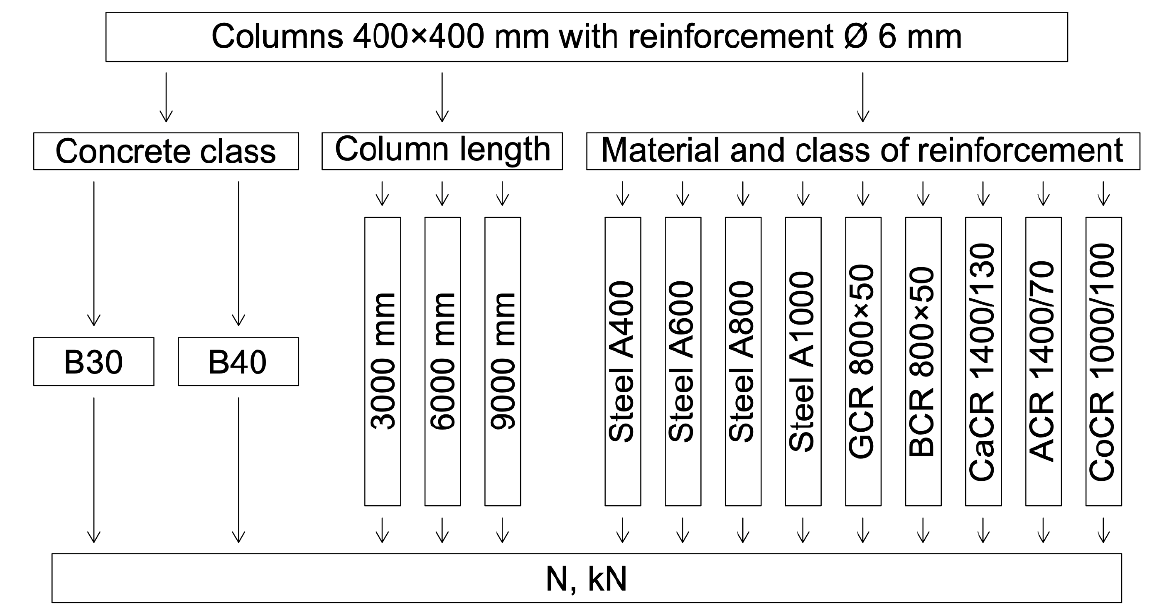
Figure 4. Plan of the numerical experiment.